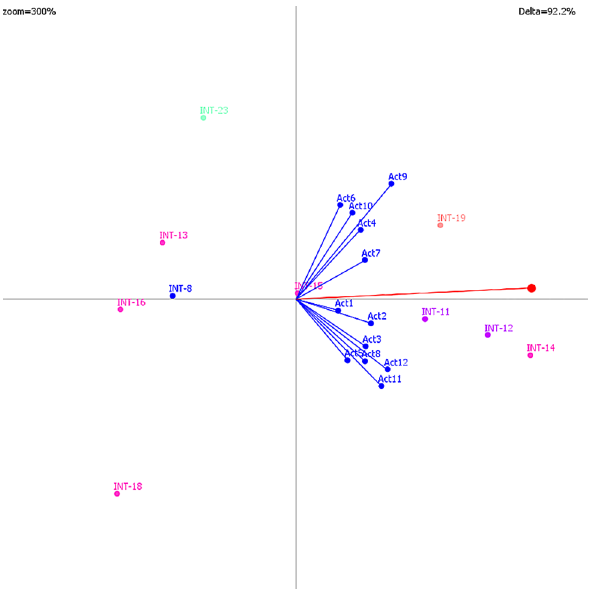
Fig 2. GAIA decision map for regional-level model under scenario 6 (high-risk transmission with interventions). Vector points Act1 through Act12 represent the 12 stakeholders in the model. Points INT-8- 23 represent the various Interventions under consideration in this analysis (see Table 2). The red vector indicates the group decision axis with preferred direction indicated by the red dot. Proximity of intervention points along the decision axis represents group ranking preference for these interventions. The relatively proximity of all stakeholder points in the same general direction as the decision axis indicates that all stakeholders are generally in agreement with the group decision axis, and no stakeholder is diametrically opposed to this decision. The close proximity of all stakeholders to one another furthermore indicates fairly strong consensus between stakeholders. There are two slightly divergent coalitions of stakeholders (1 st group consists of stakeholders above the decision axis and the 2 nd group consists of those below) indicating that these two groups have slightly different perspectives with regards to their criteria weighting, but these differences in perspective are not in conflict with the group decision axis. (Zoom = 300% and Delta = 92.2%, indicates that 92.2% of the information is conserved in the two-dimensional representation of this decision map).